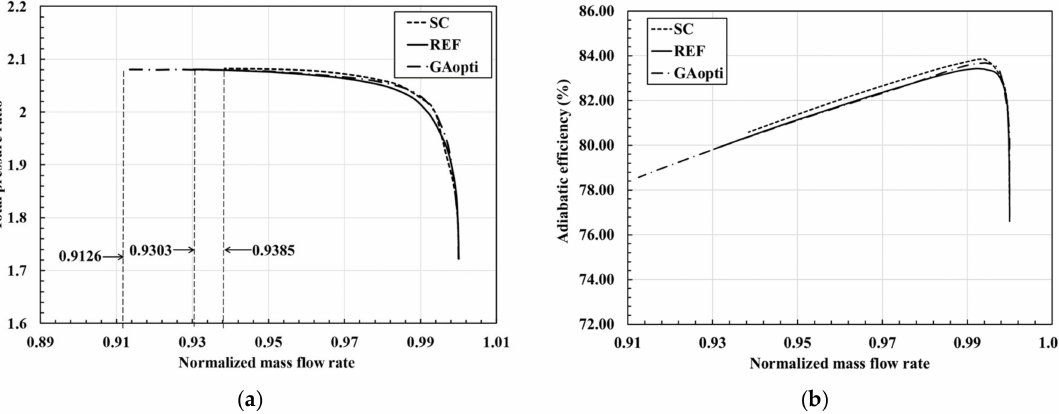
Figure 14. Performance curves of smooth casing, reference INOS and optimized INOS: ( a ) Total pressure ratio; ( b ) Adiabatic